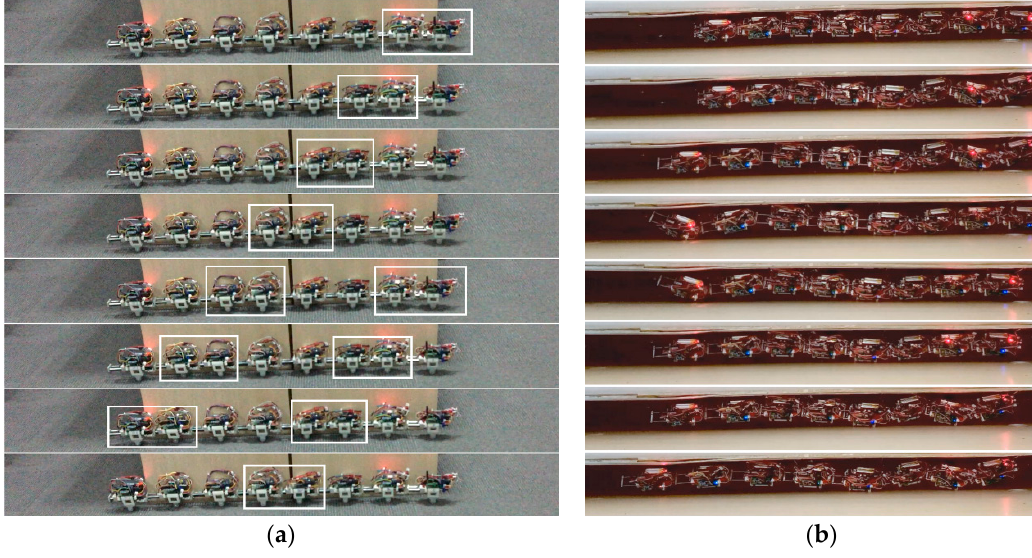
Figure 12. ( a ) Multi-wave rectilinear locomotion. ( b ) Obstacle-aided locomotion.